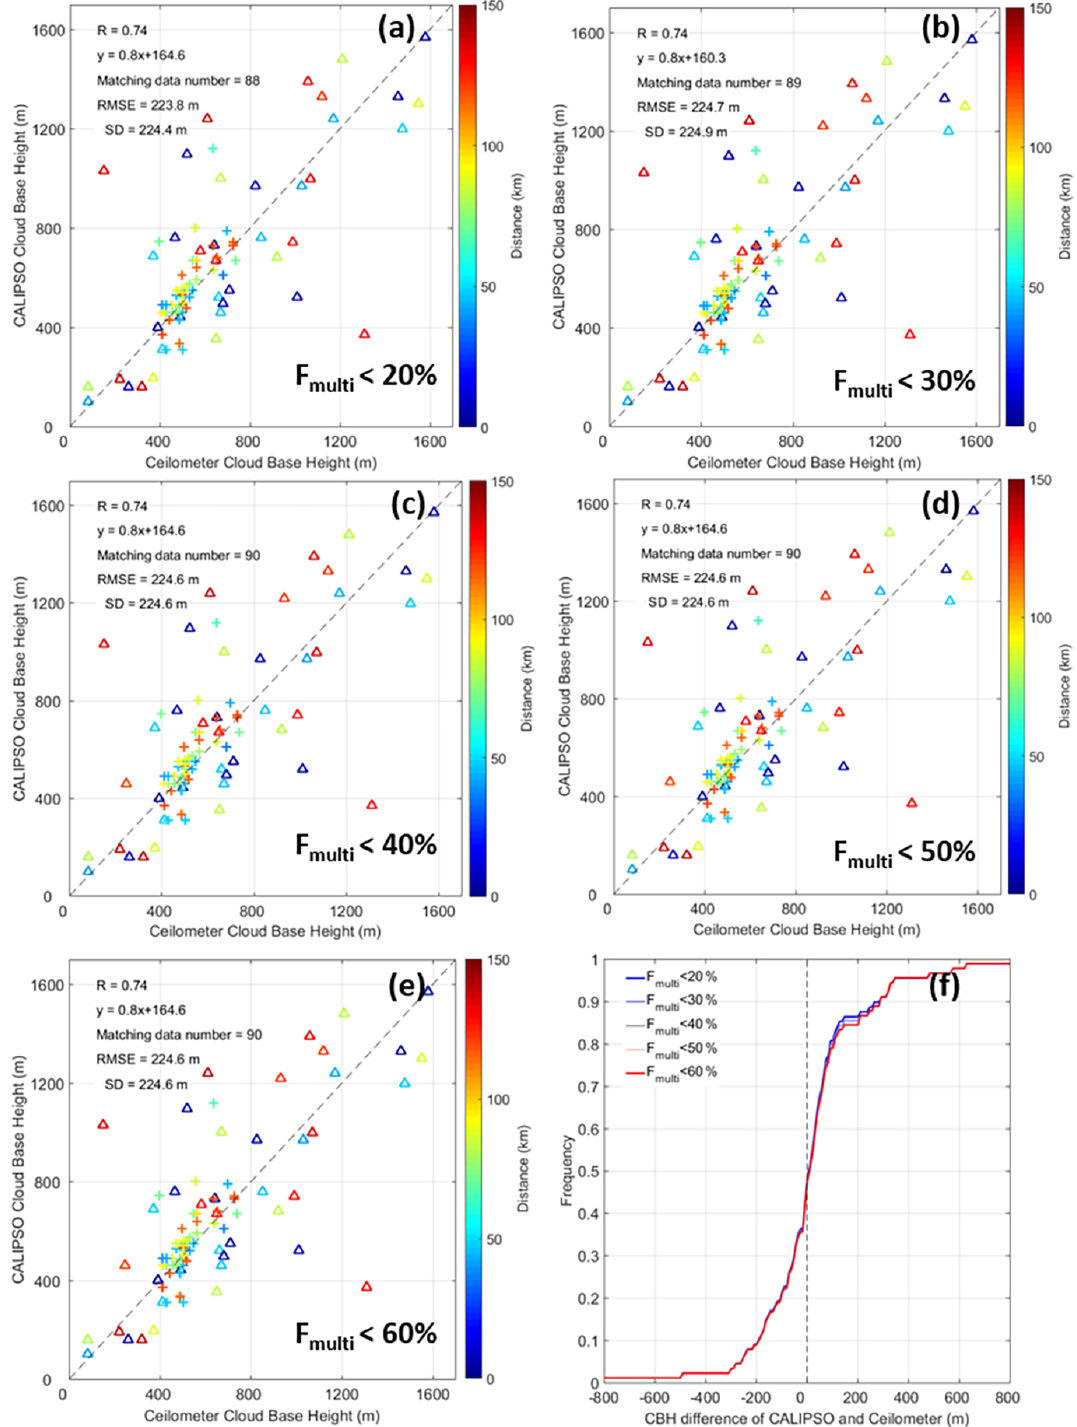
Figure 5. (a) Scatter plot of CALIPSO CBH and ceilometer-measured CBH at two marine sites in 2017, when selecting scenes with multi- layer cloud fraction ( F multi ) < 20%. The triangle represents the data for the ENA site, and the crosses represent the data for the Barbados site. The color represents the shortest distance from the CALIPSO ground track to the ceilometer site. Panels (b) , (c) , (d) , and (e) are the same as panel (a) , but the selection criteria of F multi in panel (b) are less than 30%, in panel (c) they are is less than 40%, in panel (d) they are less than 50%, and in panel (e) they are less than 60%, respectively. (f) Cumulative distribution of the difference between CALIPSO CBH and ceilometer CBH at two sites in 2017. Different colored lines represent the cumulative distribution at different selection criteria of F multi